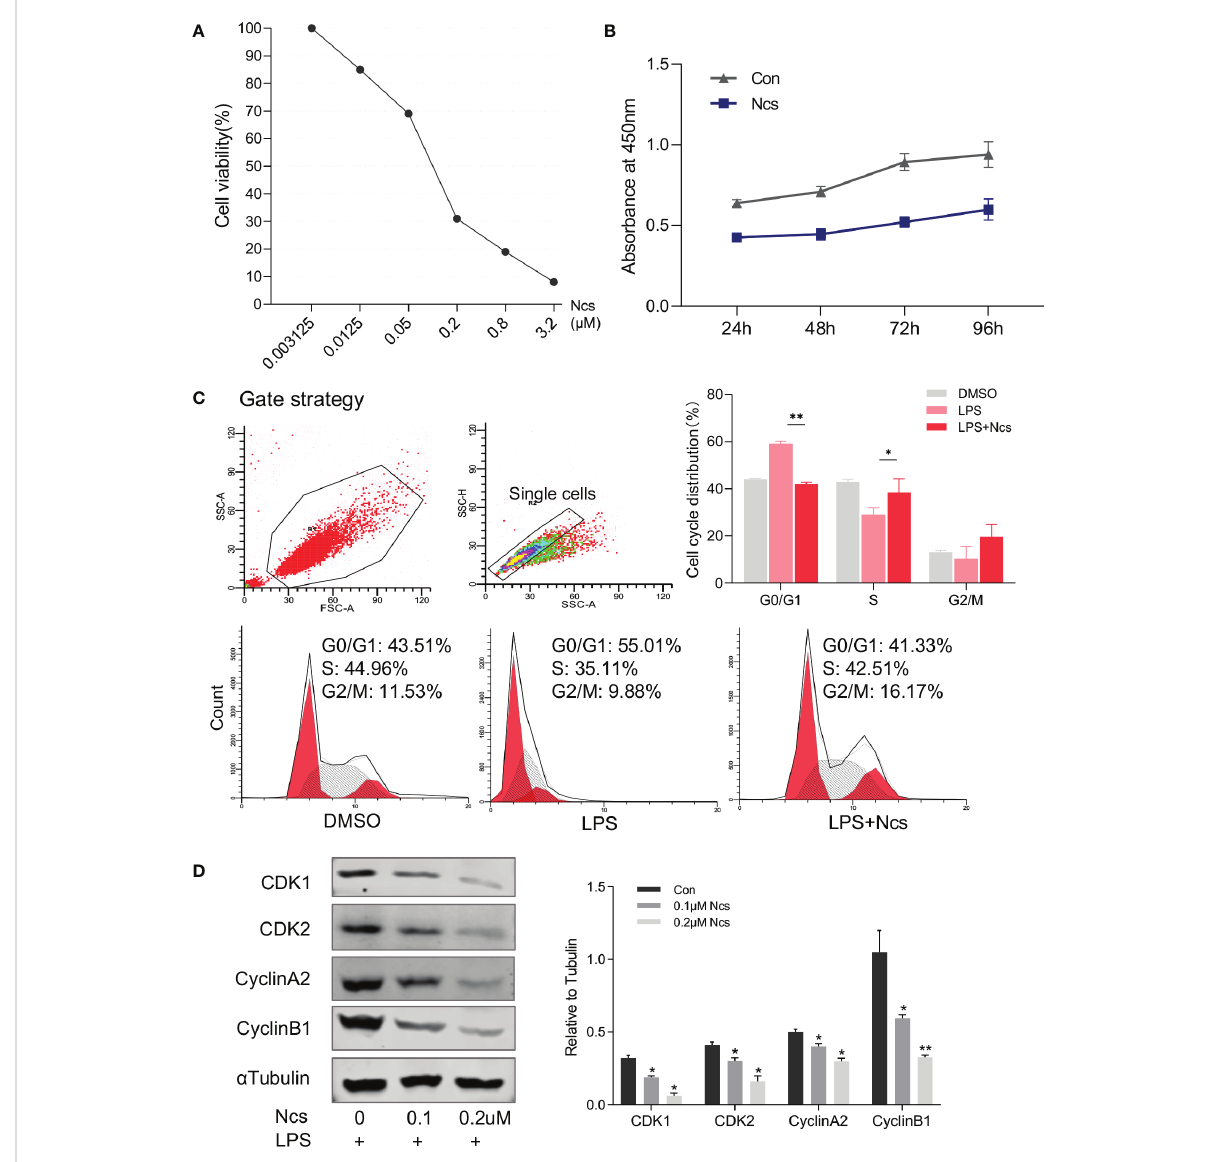
FIGURE 3 Effects of Ncs on proliferation and cell cycle of HaCaT cells. (A) HaCaT cells were cultured for 48h with gradient concentration of Ncs, and absorbance at 450nm was detected by CCK8 assay and cell survival rate was calculated. (B) LPS-primed HaCaT cells were treated with or without 0.1um Ncs for 24/48/72/96h, absorbance at 450nm was measured by CCK8 assay. (C) LPS-primed HaCaT cells were treated with or without 0.1um Ncs for 24h. Cell cycle distribution was analyzed by fl ow cytometry, with summary bar charts showing the percentage of cells in each phase. (D) Expression of cell cycle-related protein and quanti fi cation was evaluated by western blotting. Each experiment was repeated three times in HaCaT cells. Data are presented as the mean ± SEM. P-values were determined using t test by Prism 8; * p <0.05; ** p